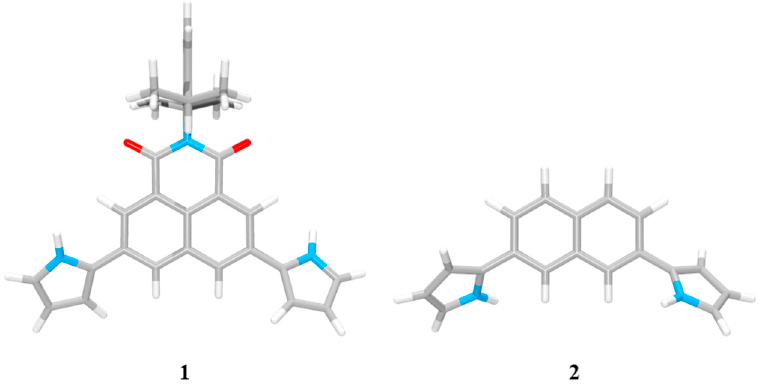
Figure 2. The lowest energy structures of receptors 1 and 2